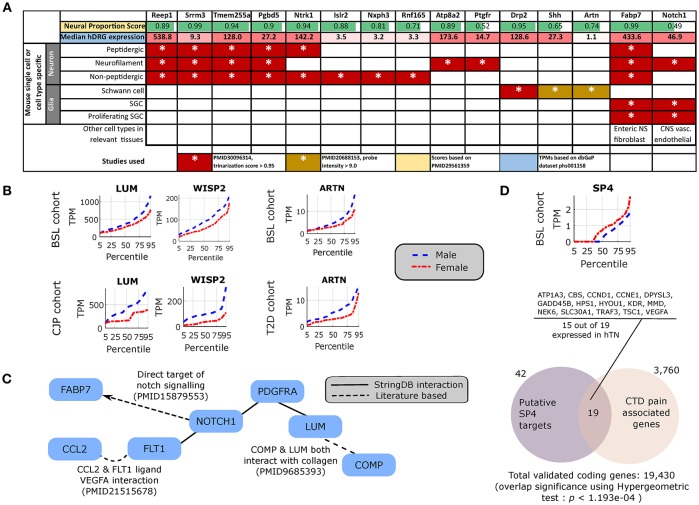
Cellular enrichment and functional roles of differentially expressed genes. (A) For DE genes that are expressed in the human DRG, enriched in neural tissues, and detected in murine PNS single cell RNA-sequencing, median expression in TPMs in the human DRG, enrichment of expression in human neural tissues [based on the human neural proportion score (Ray et al., 2018)], and murine cell types of expression in the DRG (based on Zeisel et al., 2018) are shown. (B) LUM and WISP2 show similar sex-differential expression trends in BSL and CJP, and ARTN shows similar trends in BSL and T2D. (C) Protein Interaction Network for pro-inflammatory genes that are more abundant in the male cohort, suggesting a central role of NOTCH1. (D) Quantile plot for SP4 male and female sub-cohorts, and gene set enrichment analysis showing overlap of known SP4 targets from TRANSFAC (Matys et al., 2006) expressed in the hTN and present in Comparative Toxicogenomics Database (Davis et al., 2012) based pain associated gene list.